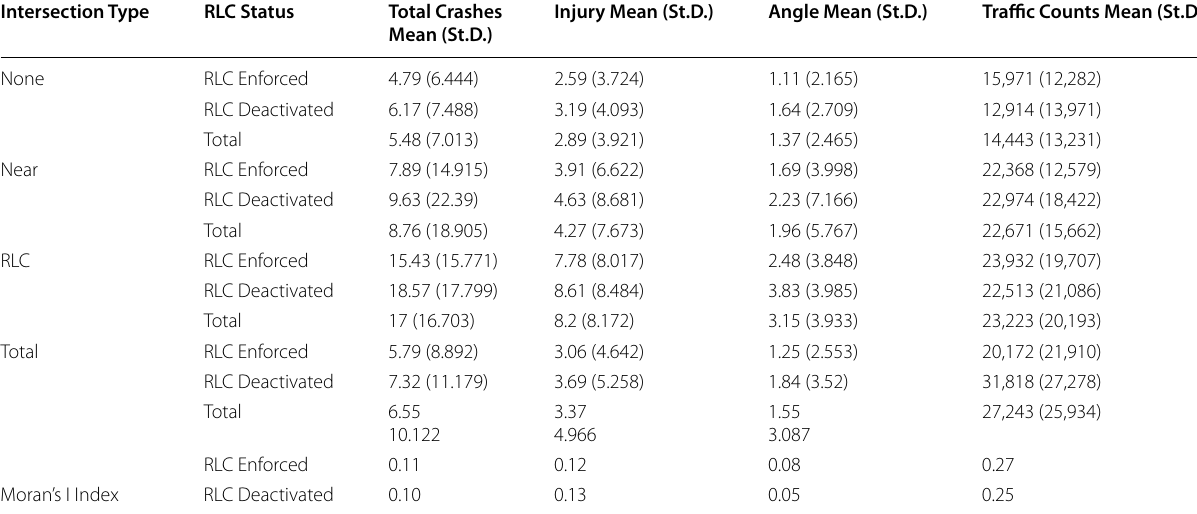
Table 3 Crashes and average daily traffic counts by intersection type Intersection